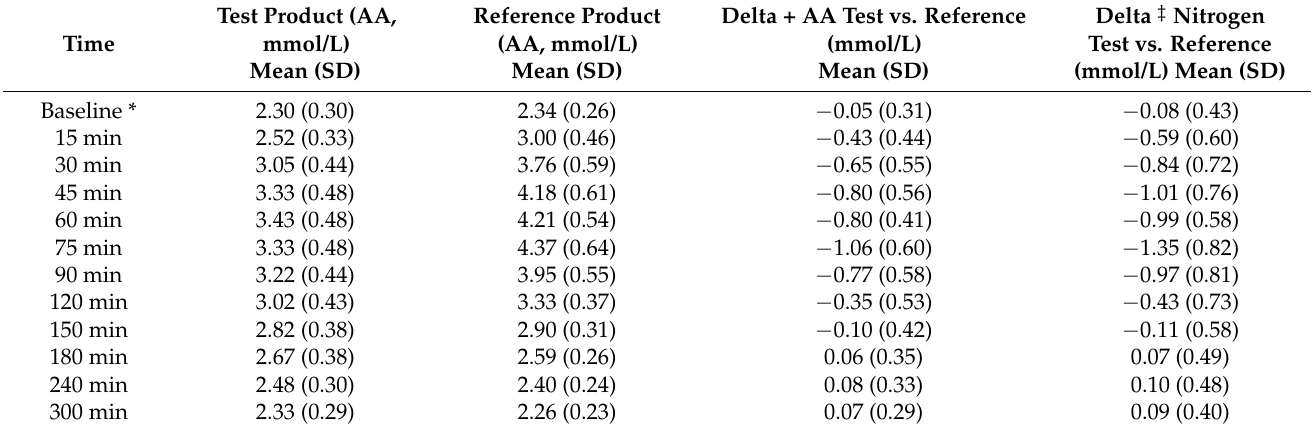
Table 1. Plasma amino acid and nitrogen concentrations after intake of the Test product and the Reference